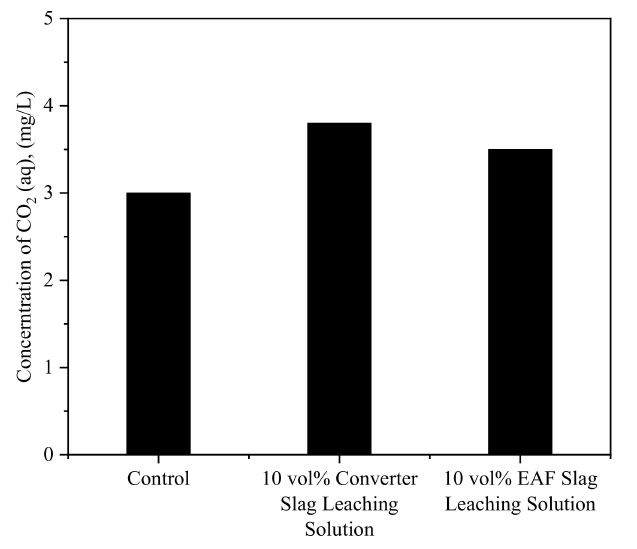
Figure 4. Concentrations of aqueous CO 2 in control, 10 vol% converter slag leaching solution and 10 vol% EAF slag leaching